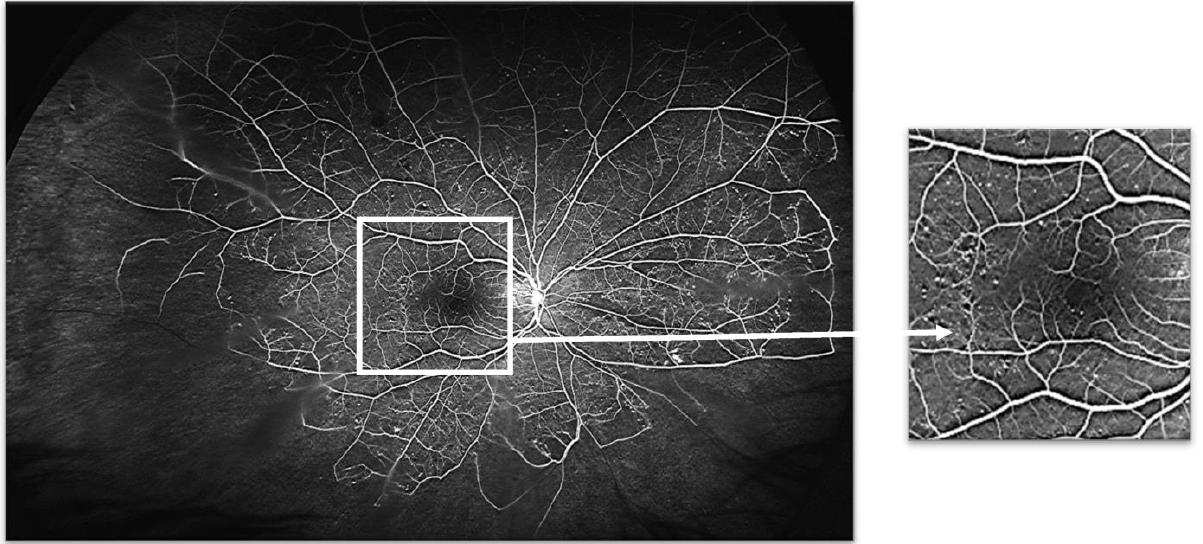
Figure 3. Venous phase of an ultra-wide field fundus fluorescein angiogram obtained from the right eye of a patient with non-proliferative diabetic retinopathy. Despite extensive midperipheral and peripheral retinal ischaemia, no new vessels are present. As findings show in Figure 2, this demonstrates also that there is great interindividual variability on the response of the retina to the insult of retinal ischaemia. Note the relatively well-preserved perifoveal capillaries (for details, see inset, right).